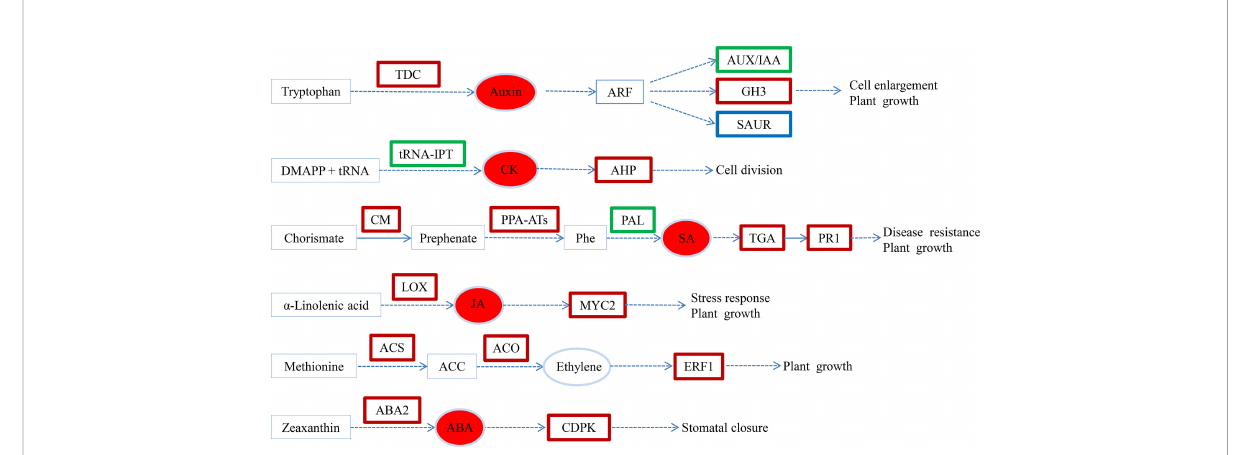
FIGURE 7 Transcriptional changes in hormone biosynthesis and signaling pathways in SM compared to SW. Upregulated, downregulated and both up- and downregulated genes are boxed in red, green and blue, respectively. The solid arrow indicates a direct step, and the broken arrow indicates an indirect step. SW (hypocotyl shaded and irrigated with water), SM (hypocotyl shaded and irrigated with 100 µM